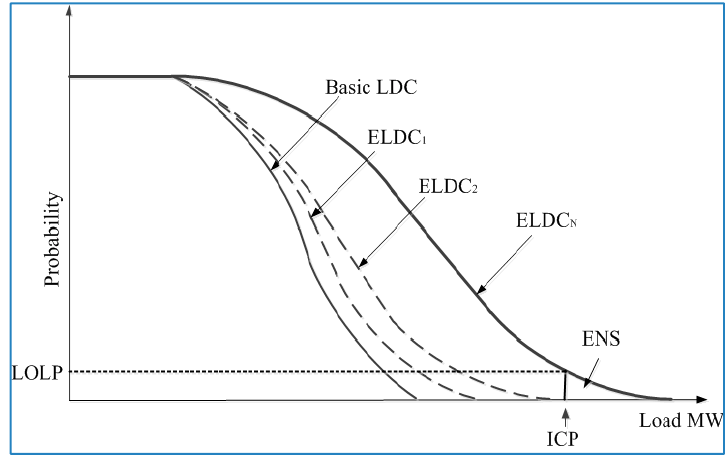
Figure 1. Calculation of the equivalent load duration curve.